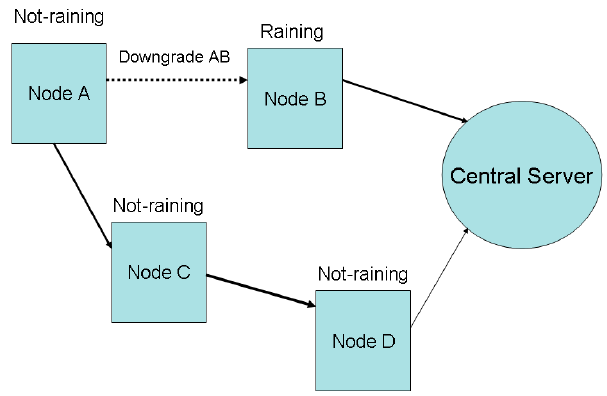
Figure 2. Routing decisions made based on external events.